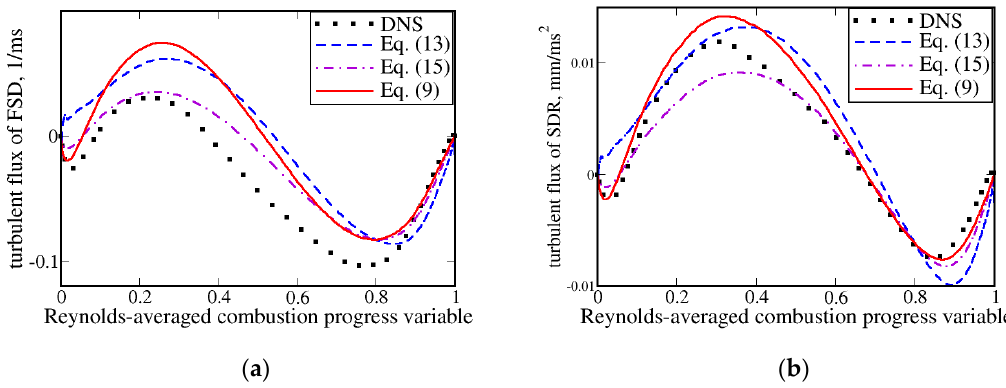
Figure 6. Turbulent axial fluxes of (a) FSD Σ and (b) SDR χ . Case L.